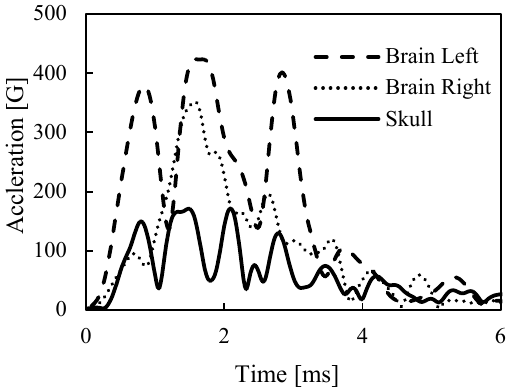
Figure 6. Resultant linear acceleration responses at the Brain Left, Brain Right and Skull points, where 6DOF sensors were inserted, in the case of the impact tests.